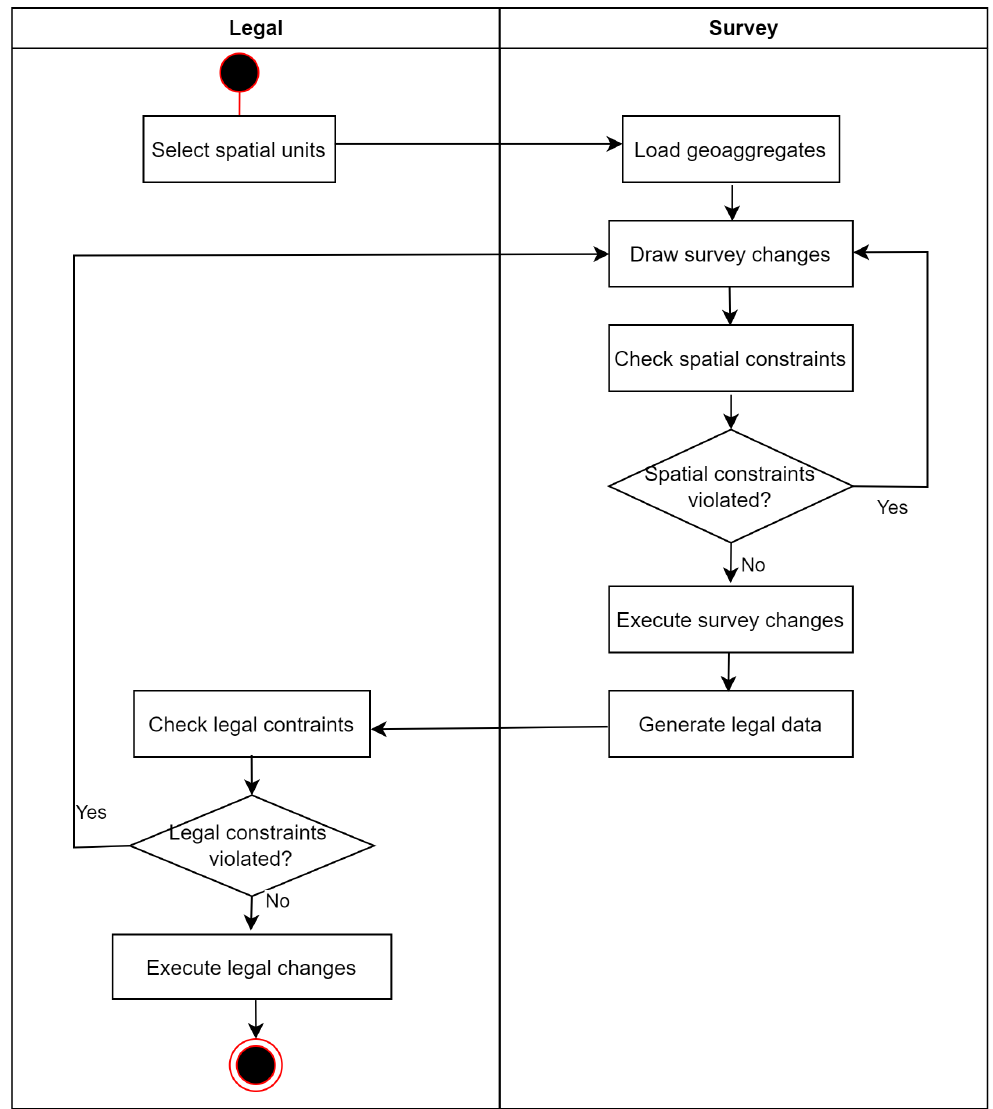
Figure 5. Simple parcel division activity